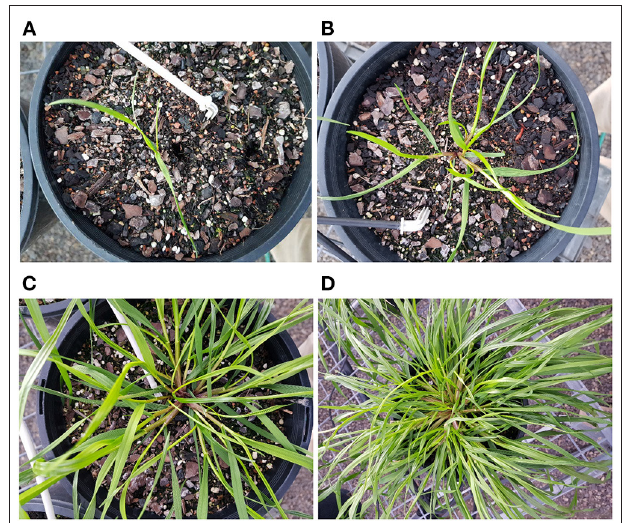
FIGURE 1 | Indicative plant sizes for the four annual ryegrass growth stages treated (A) three-leaf, (B) seven-leaf, (C) mid-tillering, and (D) late-tillering before laser treatment.